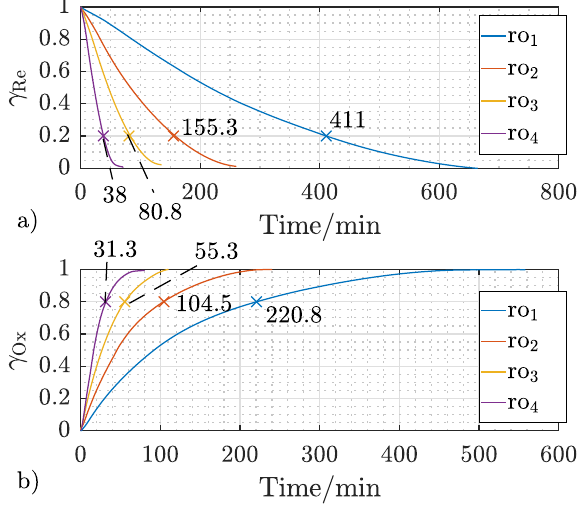
Figure 5. Effect of the gas concentration ro 1 to ro 4 (cf. Table 2) on the temporal reduction ( a ) and oxidation ( b ) fractions of S1 at a reactant flow rate of 250mL/min and the reaction temperature of